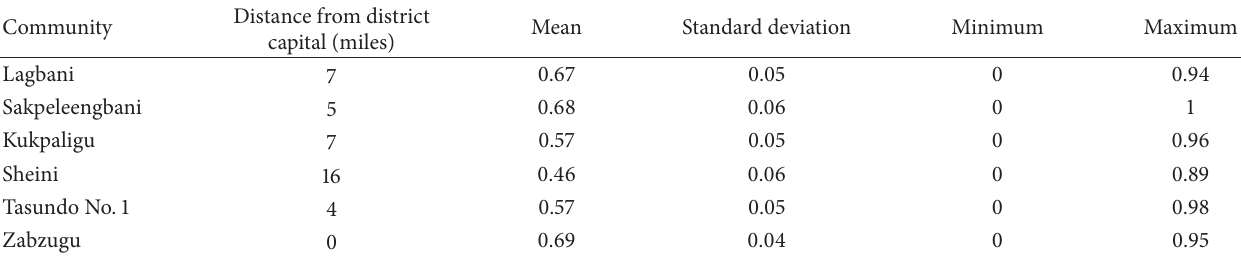
Table 1: Distribution of PMC across communities in the study area.